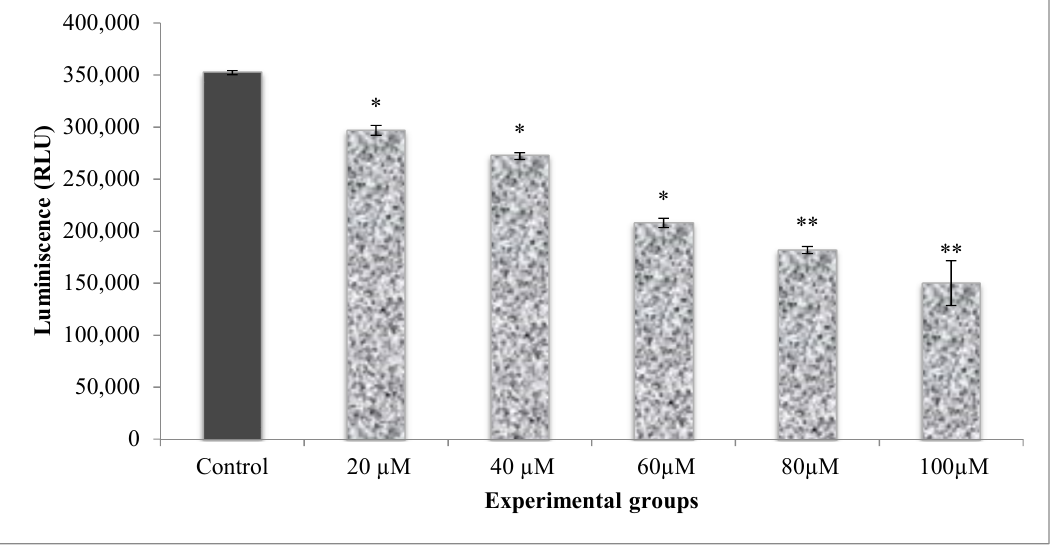
Figure 5. Dose-response analysis of CA on A549 cell proliferation as measured by cellular ATP. The amount of cellular ATP was estimated in terms of RLUs. A dose-dependant decrease in the ATP luminescence corresponding to the cell proliferation in CA treated A549 cells was observed. Values presented as mean ± SE from independent duplicate experiments; n = 4. * p < 0.05, ** p < 0.01. Molecules 2020 , 25 , x FOR PEER REVIEW